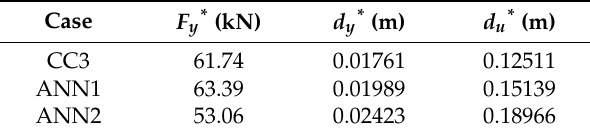
Table 7. Results obtained for the control case n.